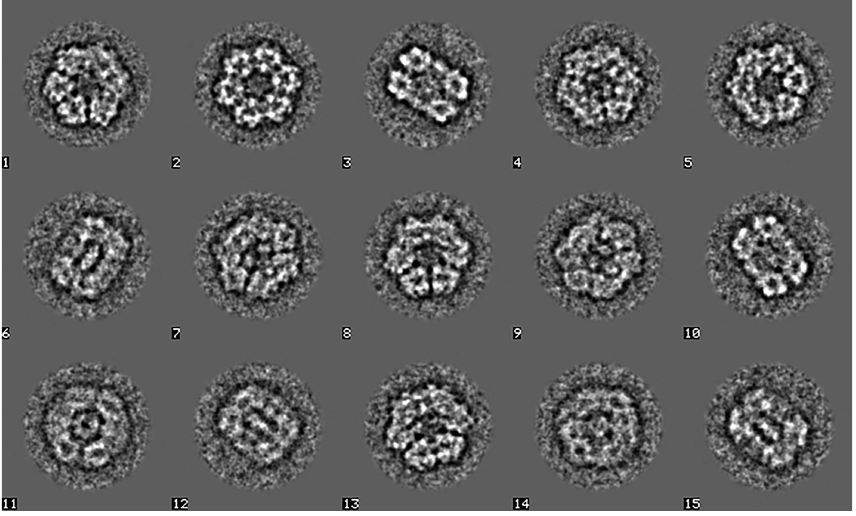
Figure 7 15 class averages of unaligned particles (‘alignment by classification’; ABC) used for an initial ‘random-startup’ three-dimensional reconstruction. Class average 2 corresponds to a top view and class averages 3 and 10 correspond to side views. The other class averages represent various intermediate projection images of the haemoglobin. Since the input images are coarsened (binned) by a factor of four, no information beyond the Nyquist frequency of 1/8.8 A˚ can be present in the images at this